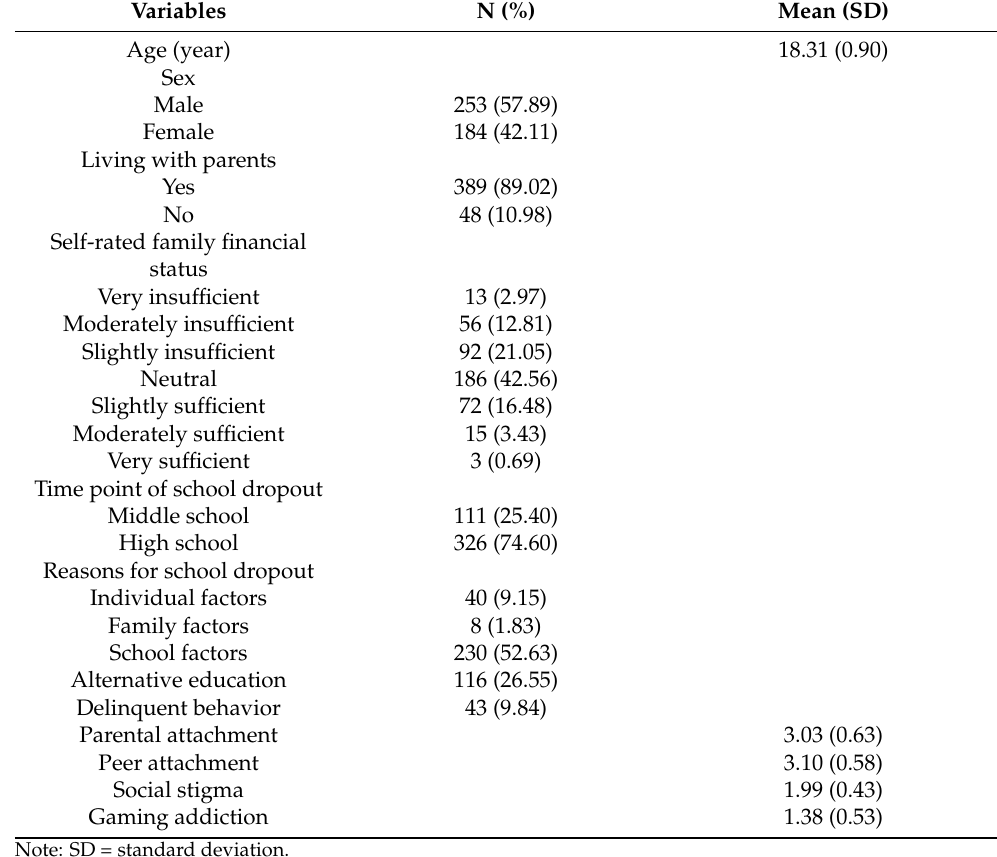
Table 1. Descriptive statistics ( n = 437).